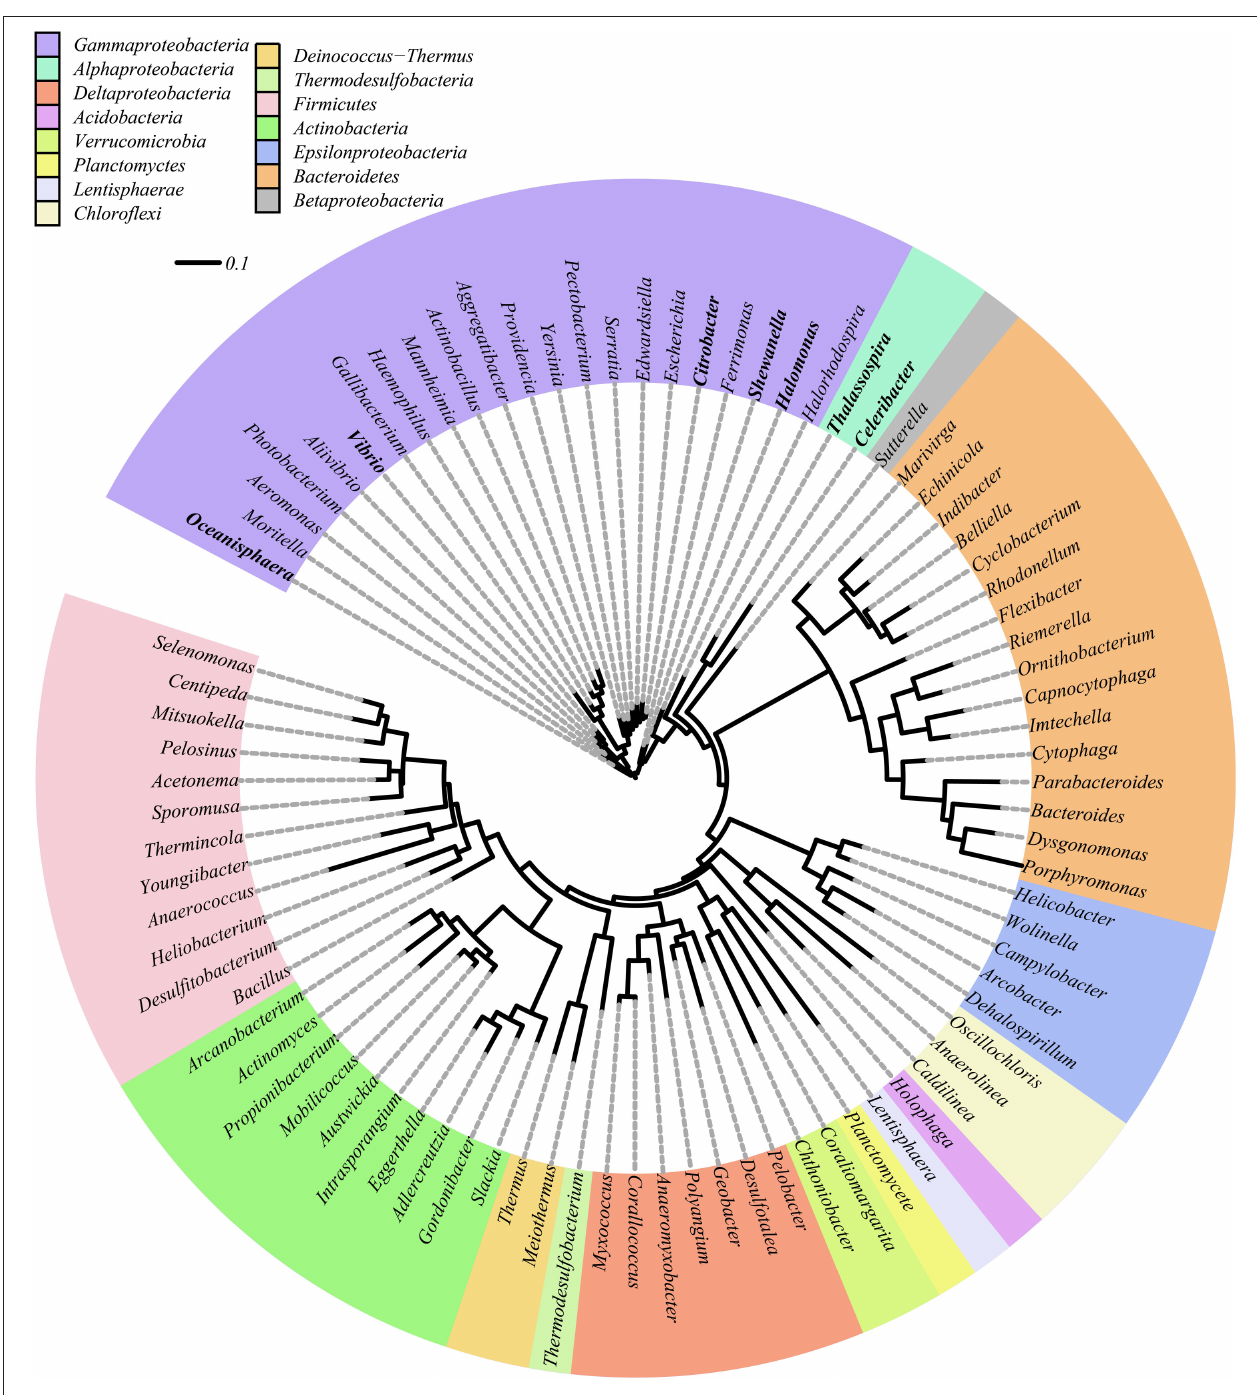
FIGURE 2 | Maximum likelihood phylogenetic analysis of 16S rRNA genes of previously known DNRA bacteria as determined by the presence of a nrfA gene. Genera found during this study are indicated in bold.